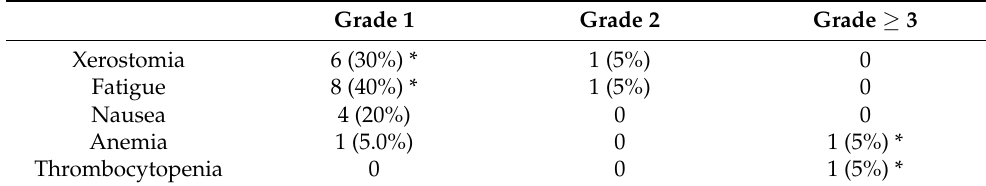
Table 2. Adverse events, possibly related to PSMA-RLT In 20 mHSPC patients. Grade 1 Grade 2 Grade ≥ 3 Xerostomia 6 (30%)